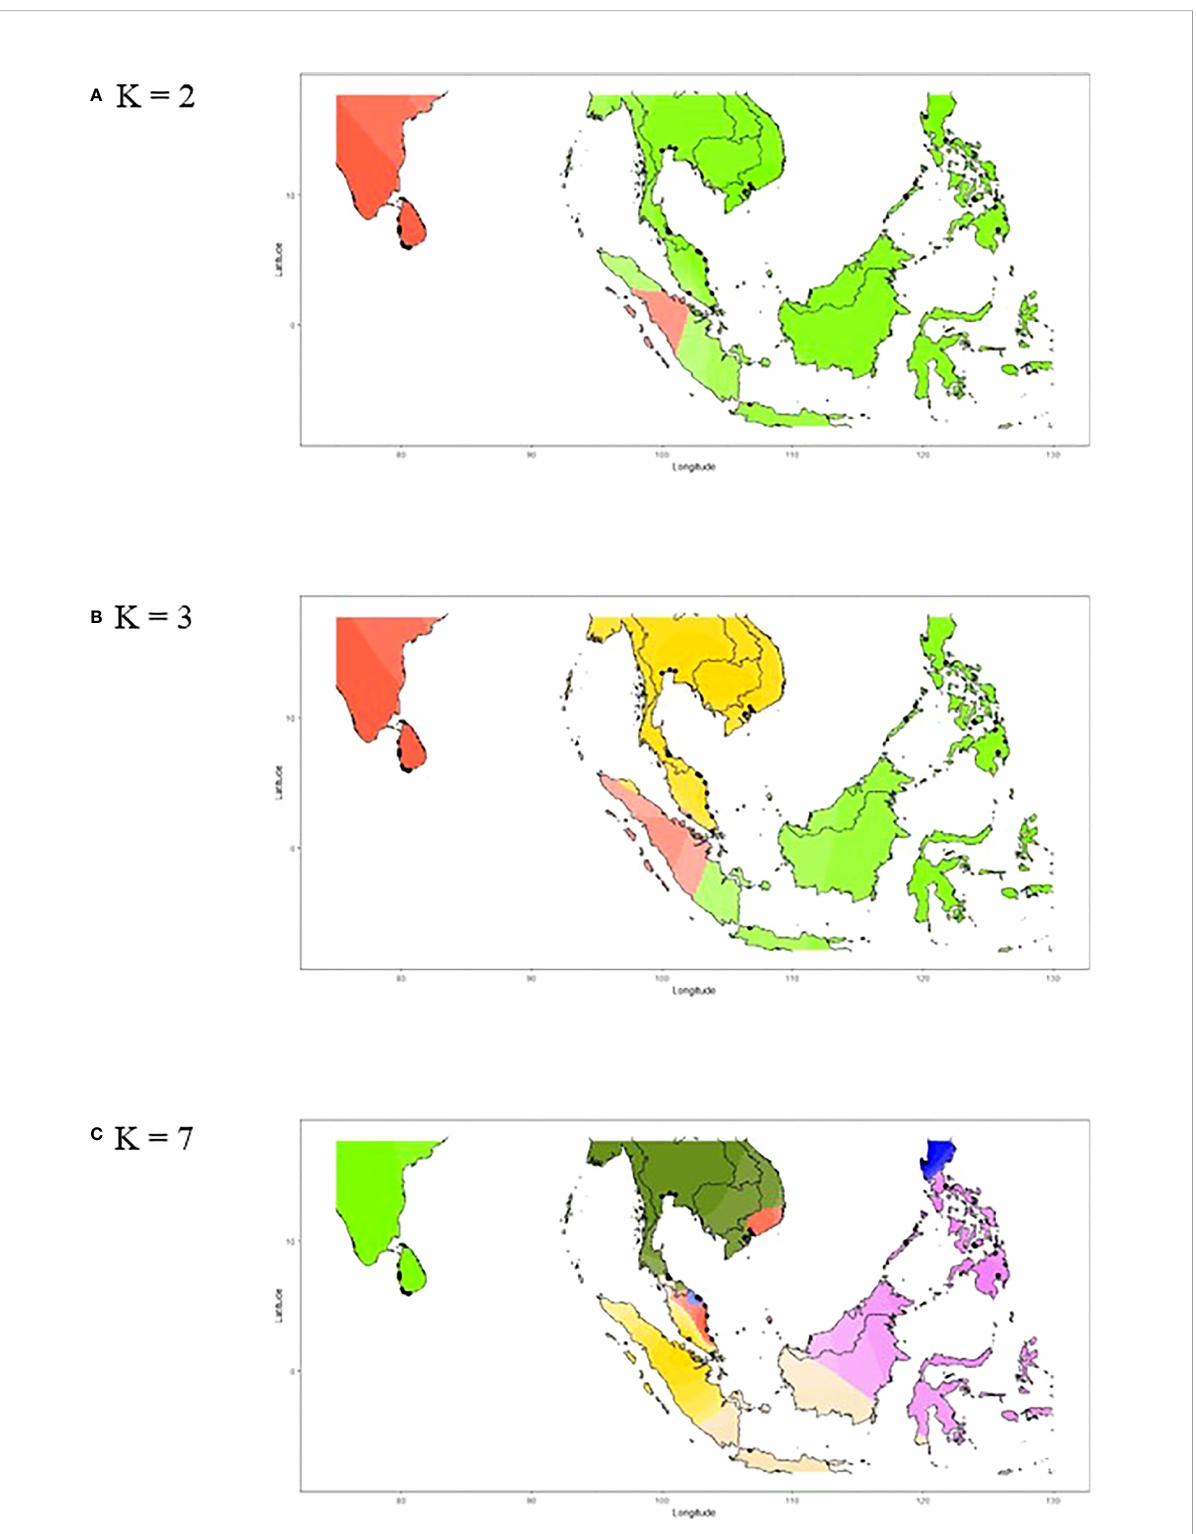
FIGURE 6 The ancestry coef fi cients of nipa individuals across the Indo-West Paci fi c. (A) K = 2, (B) K = 3, and (C) K = 7 based on the individual Q-matrix of STRUCTURE as interpolated by R using tess3r